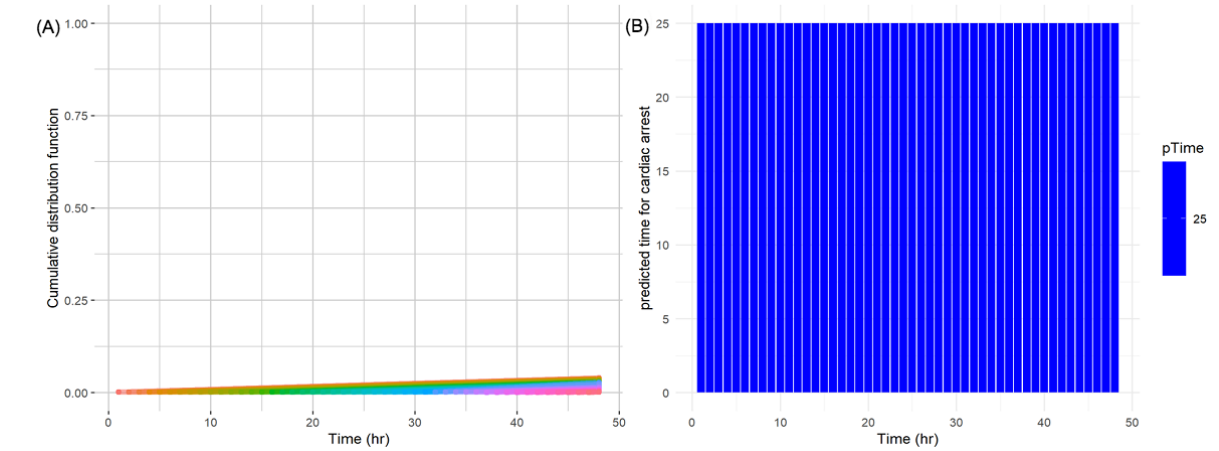
Figure 7. (A) Cumulative distribution function lines from the predicted time point to censoring time point for a patient without cardiac arrest at 48 time points; Each function line is color-coded. (B) Predicted hours remaining until a patient has cardiac arrest; the y-axis was limited to less than 25 hours for readability. pTime: predicted